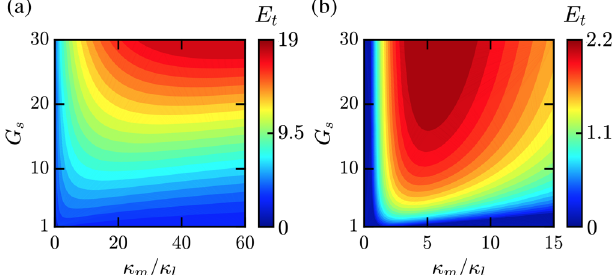
FIG. 2. The scan rate enhancement E t , calculated as a function of SQ single-quadrature power gain G s and coupling ratio κ m = κ l . (a) With perfect efficiency, i.e., η ¼ 1 , E t grows steadily with G s and κ m . (b) When η ¼ 0 . 69 , it plateaus at 2.2 for κ m = κ l ¼ 5 and G s > 20 . The color scales for panels (a) and (b) differ by close to a factor of